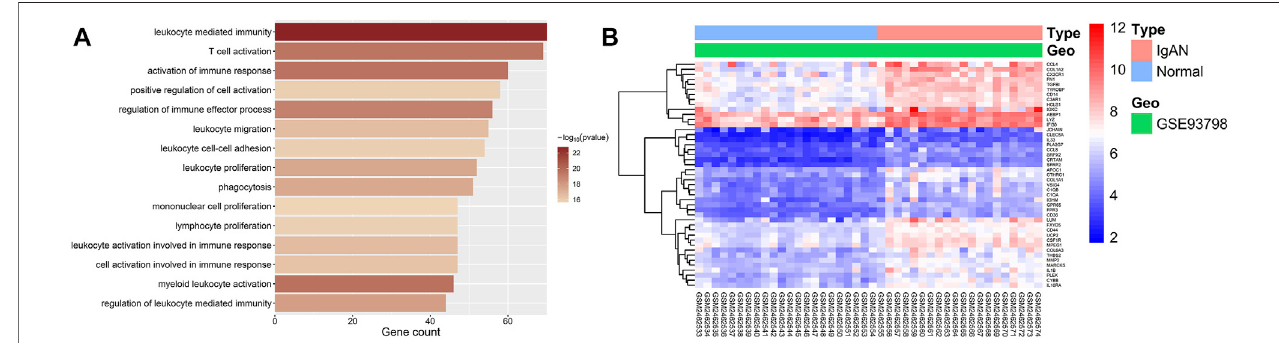
FIGURE 5 | GO enrichment and DEG analysis of two trait-related modules. (A) Bar graphs showing the top 15 signi fi cantly enriched GO biological process (BP) terms in the IgAN-related and immune-involving module (black module). The shading of color represents the enrichment signi fi cance of each term, and the x -axis indicates the enriched gene count. (B) Heatmap of DEGs enriched in GO-terms in the IgAN-related and immune-involving module. The color of each cell represents the expression level of a gene in a sample (red for high level and blue for low